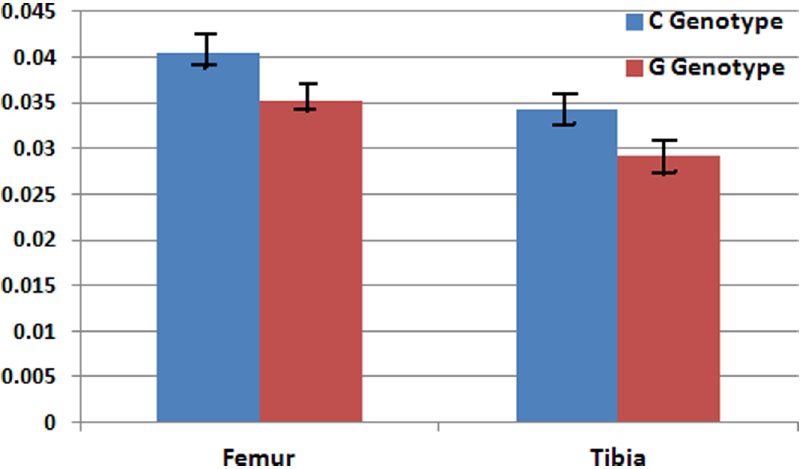
Figure 2. Trps1 as the candidate gene for BMD in male. BMD of ‘‘G’’ and ‘‘C’’ genotypes of femur and tibia in male mice.